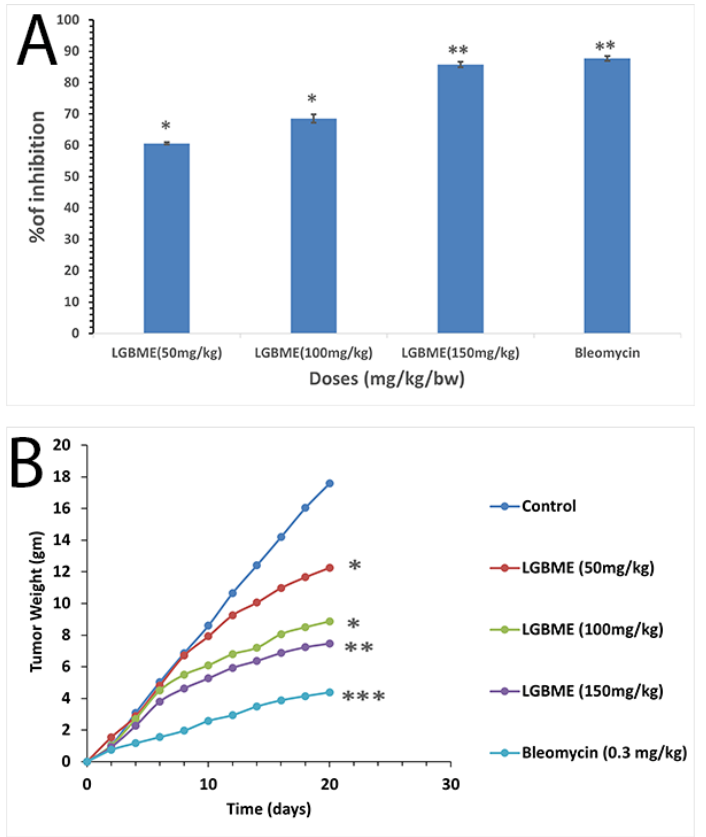
Figure 3. Anticancer activity of LGBME. ( A ) Effects of LGBME on EAC cell ‐ growth inhibition; ( B ) effects of LGBME on tumor weight of EAC ‐ bearing mice; results are shown as mean ± SD ( n = 6), where significant values are set as * p < 0.05, ** p < 0.01, and *** p < 0.001 for treated (EAC + LGBME) mice compared with EAC ‐ bearing control mice. Table 4. Effect of LGBME on MST and %ILS on EAC ‐ cell ‐ bearing mice . Table 5. Effects of LGBME on hematological parameters in EAC-bearing